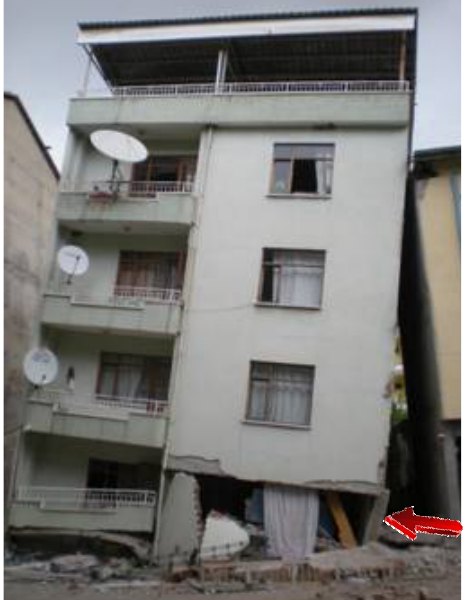
Figure 8. Building collapse due to first story failure during the Simav